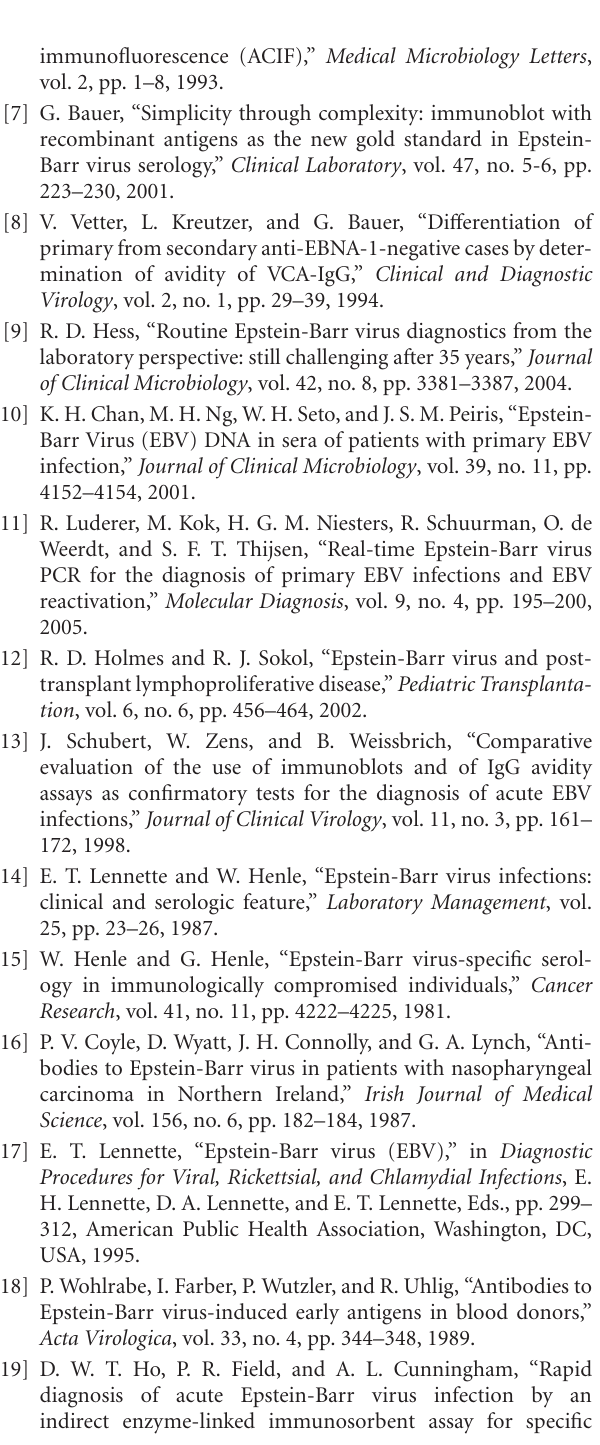
Table 3: Correlations between the presence of anti-EA(D) antibodies and antibody specificity at EBV immunoblotting. Anti-EA(D) Anti-EBV at immunoblotting No. antibodies gp250/350 p54 p72 p138 p23 p18 Positive 37 11 (29.7%) 34 (91.9%) 12 (32.4%) Negative 93 22 (23.7%) 13 (14.0%) 58 (62.4%) 24 (25.8%) 89 (95.7%) 92 (98.9%) P NS < .01 < .01 < .01 NS < .01 NS: not